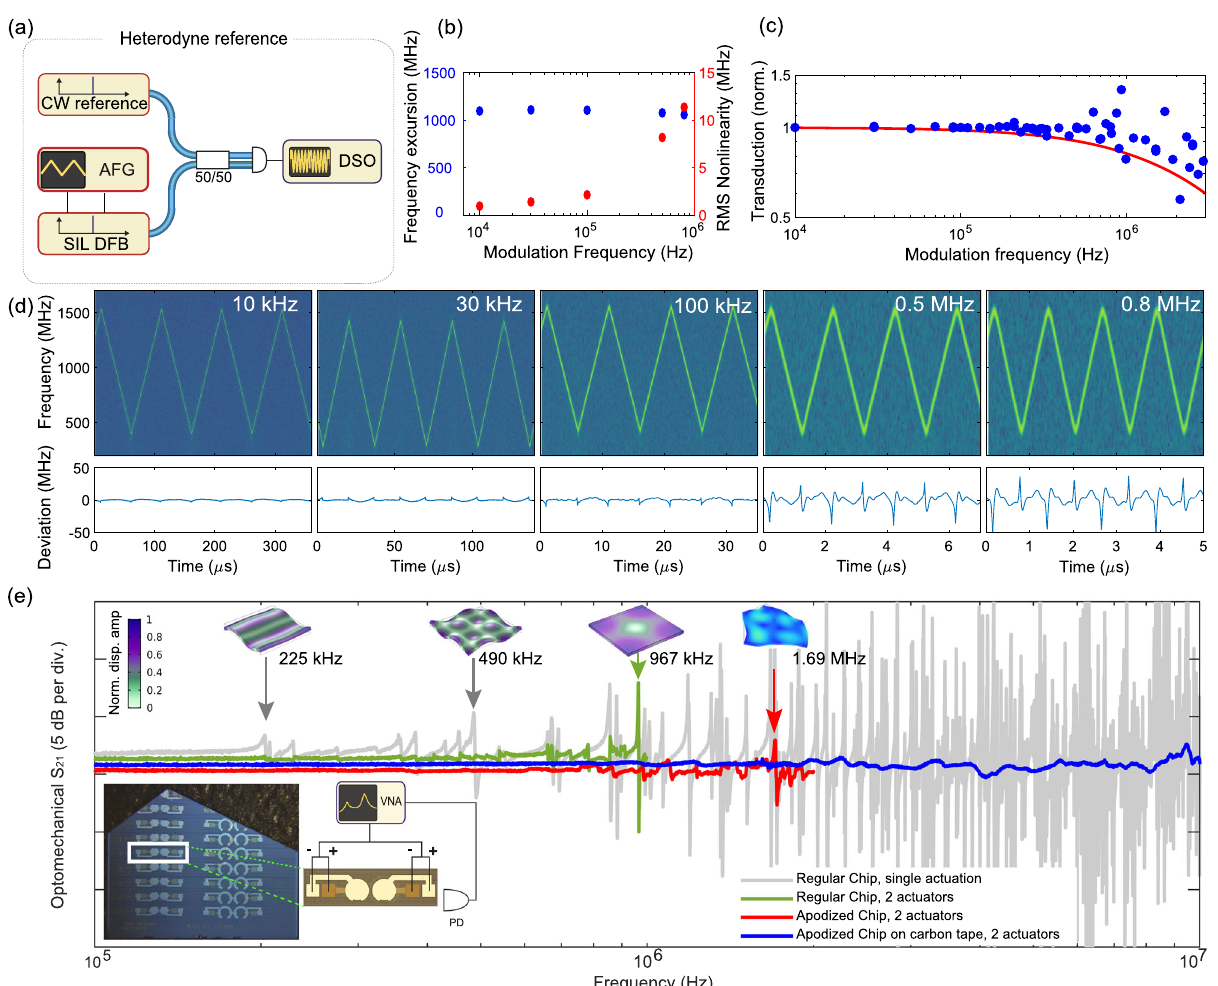
Fig. 3 Frequency-agile tuning with integrated AlN piezoactuator. a Experimental setup for heterodyne beat note characterisation of the frequency-agile hybrid-integrated laser. A continuous-wave (CW) external-cavity diode laser is used as a reference, and the beatnote is recorded on a fast oscilloscope (DSO) and analysed with short-time Fourier transforms. b Frequency excursion (blue) and residual root-mean-square (RMS) nonlinearity (red) of triangular laser chirps. The AlN actuator is driven with a peak-to-peak amplitude of 150 V. c Piezo-voltage to laser frequency transduction is calculated from the harmonic spectral content of the laser frequency chirp and the best fi tted perfect triangular frequency chirp (red). d Time-frequency spectrogram of the heterodyne beat-notes for different triangular chirp repetition frequencies. Bottom row: residual of least-squares fi tting of the time-frequency traces with symmetric triangular chirp pattern. e Suppression of photonic chip mechanical resonances. Measured responses of the stress-optic actuation for 190.7 GHz FSR microresonator using disk-shaped piezoactuator with single actuation (grey), dual actuators with difference-actuation for a square Si 3 N 4 chip (green), an apodized chip (red) and an apodized chip on a carbon tape (blue). Insets: three mechanical modes of regular Si 3 N 4 chip (225 kHz, 490 kHz, 967 kHz) and apodized chip (1.69 MHz) simulated with FEM, eigenfrequencies denoted by the arrows with displacement amplitude pro fi le visualisation. Lower left: photo of the apodized chip with the dual-actuator con fi guration, exact chip dimensions are provided in the SI. Experimental schematic for difference driving of dual